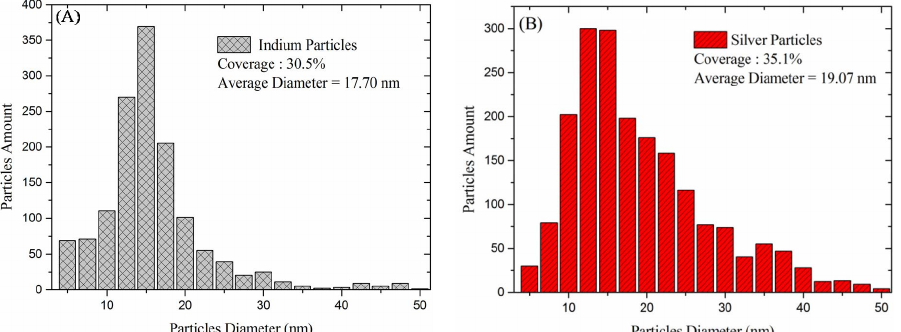
Figure 4. Particle diameter distribution and coverage: ( A ) In-NPs and ( B ) Ag-NPs. These values were calculated by analyzing the SEM images in Figure 3A,B using J-image software.